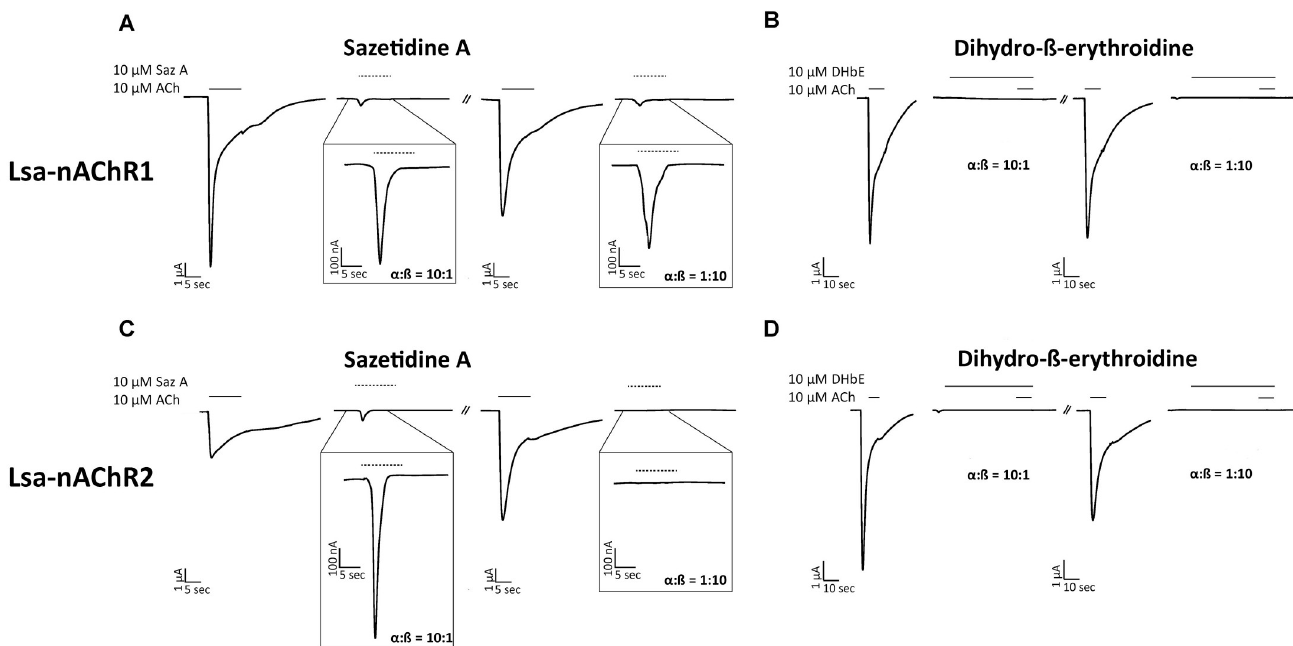
Fig 5. Effect of two different α : β ratio on Lsa-nAChR1 and Lsa-nAChR2 sensitivity to sazetidin A (Saz A) and dihydro- β -erythroidine (DHbE). Typical current traces obtained with 10 μ M Saz A (A and C) or 10 μ M DHbE (B and D) obtained from oocytes expressing two different ratios of α : β Lsa-nAChR1 (A and B) or Lsa-nAChR2 (C and D) are shown. The bars indicate the time period of ACh (black line), Saz A (interrupted line), or DHbE (grey line). The traces obtained with Saz A are also represented with a smaller scale to allow a better visualization of the peak currents